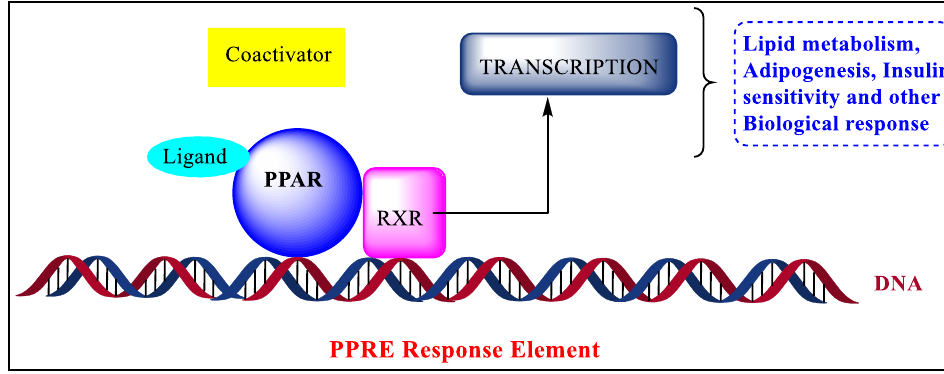
Figure 1. Mechanism of biological responses through PPAR.